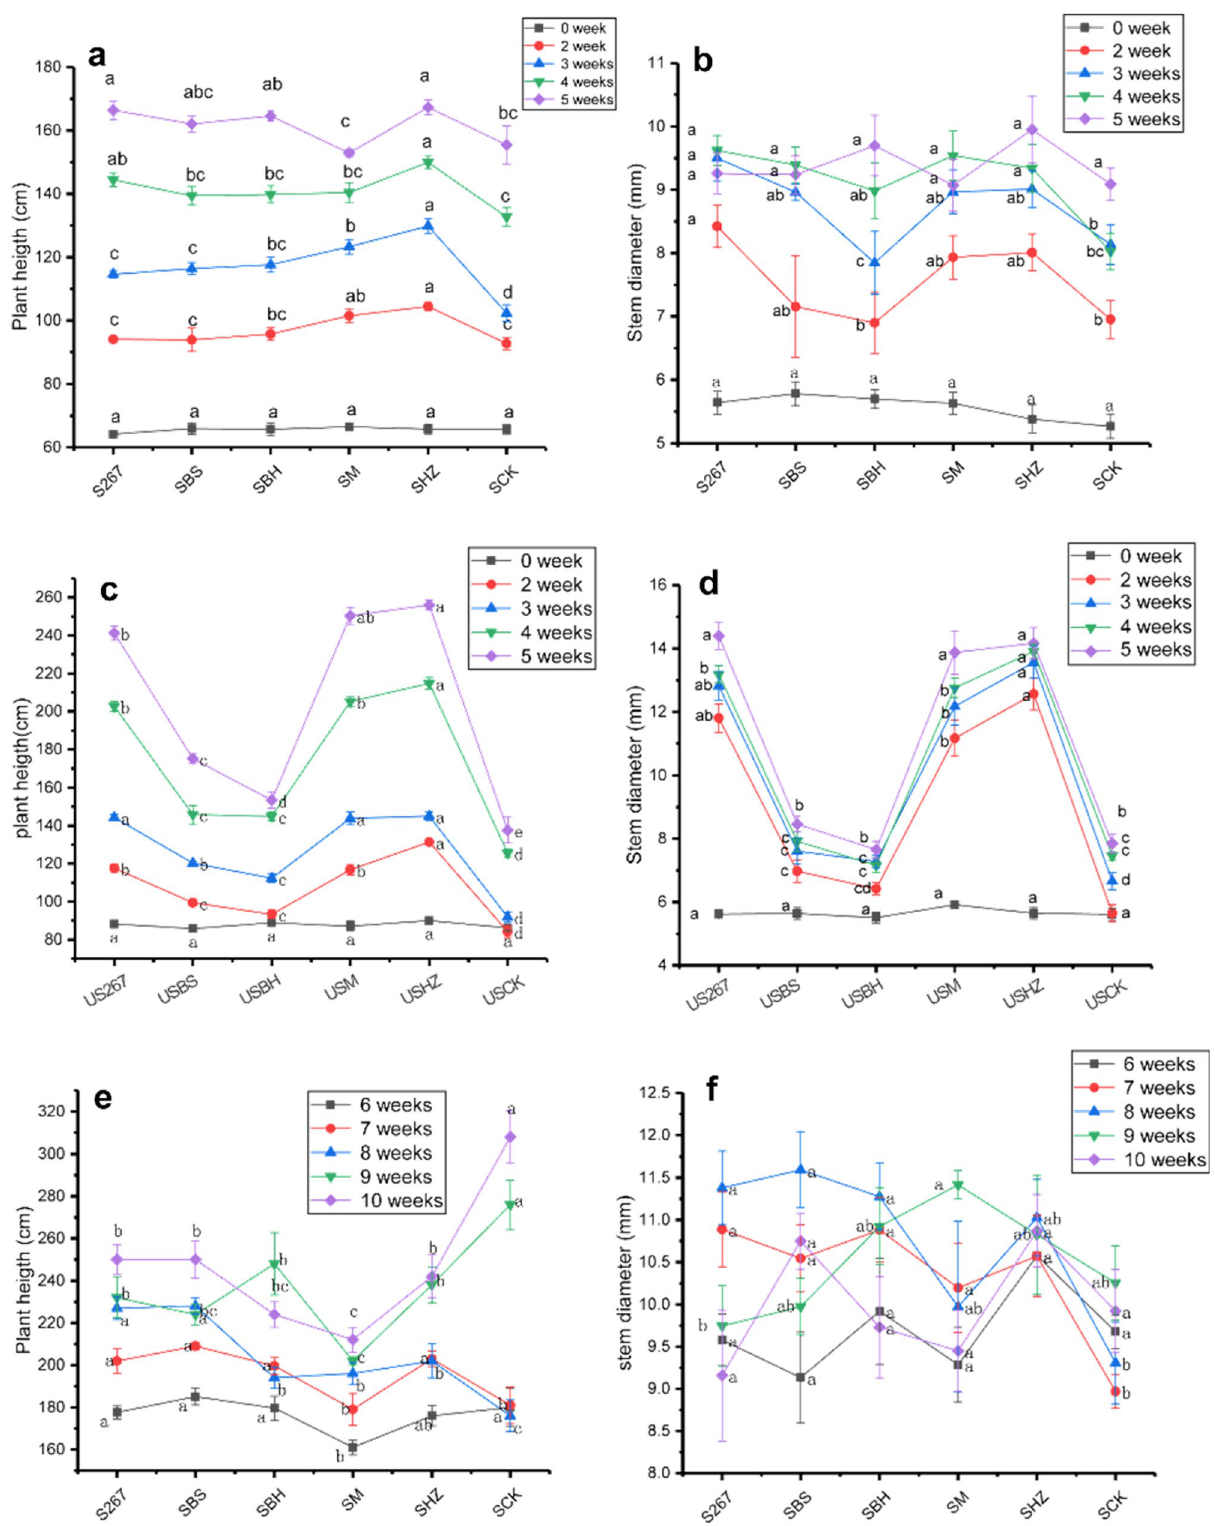
Figure 1. Effect of different biofertilizer treatments on the growth of cucumber seedlings produced in soil or substrate in a greenhouse. S267 = Trichoderma Strain 2 67 added to soil; SBH = Bacillus subtilis and T. harzianum biofertilizers added to soil; SBS = B. subtilis biofertilizer added to the soil; SM = Compound biofertilizer added to soil; SHZ = T. harzianum biofertilizer added to soil; SCK = Untreated soil. US267 = T. 267 biofertilizer added to substrate; USBH = B. subtilis and T. harzianum biofertilizers added to substrate; USBS = B. subtilis biofertilizer added to substrate; USM = Compound biofertilizer added to substrate; USHZ = T. harzianum biofertilizer added to substrate; USCK = Untreated